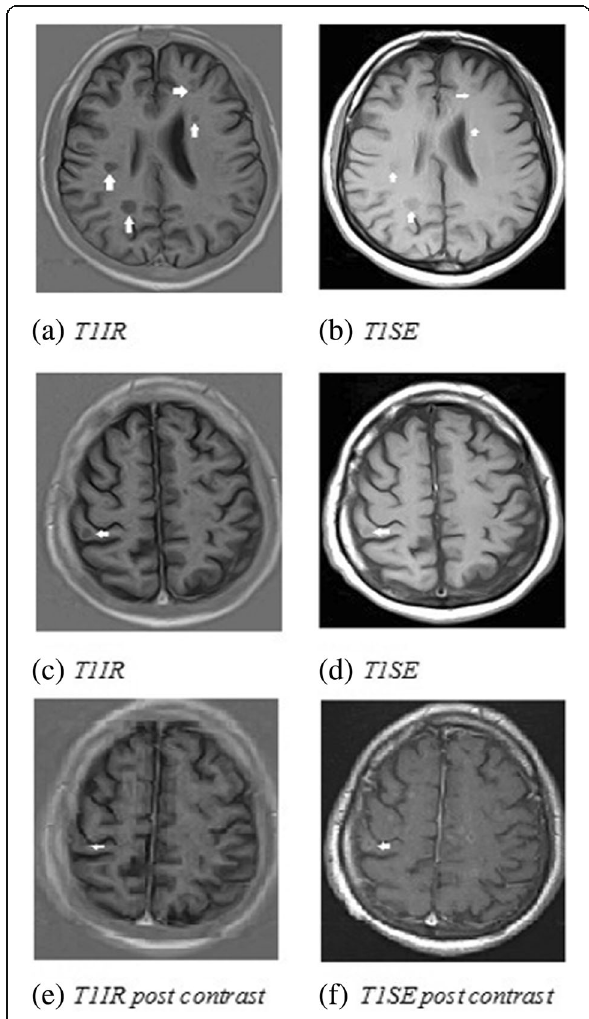
Fig. 3 Male patient, 50years old, diagnosed as metastatic bronchogenic carcinoma to the brain. a T1IR. b T1SE. It revealed that T1IR aided in better delineation of lesions and also in detection of lesions (arrows in a ) that were not clearly seen in T1SE (arrows in b ). c T1IR. d T1SE. It revealed that T1IR showed a right cortical lesion (arrow in c ) that was barely detected in T1SE (arrow in d ) . e T1IR post- contrast. f T1SE post-contrast. The right cortical lesion enhancement could not be assessed accurately in T1IR post-contrast image due to motion artifacts (arrow in e ), and there was also a faint ring enhancement in this lesion in T1SE post-contrast image (arrow in f